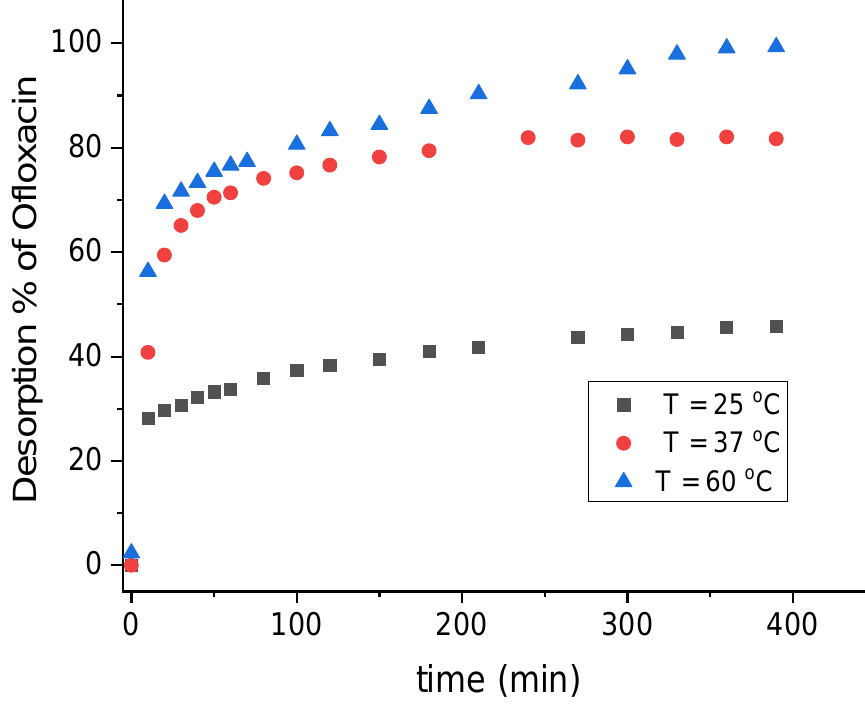
Figure 15. OFL % desorption versus time plot recorded upon immersing the OFL-containing PMMA x - co -PDEAEMA y /PVP/Fe x O y crosslinked fibrous membrane in an alkaline aqueous solution at various temperatures.